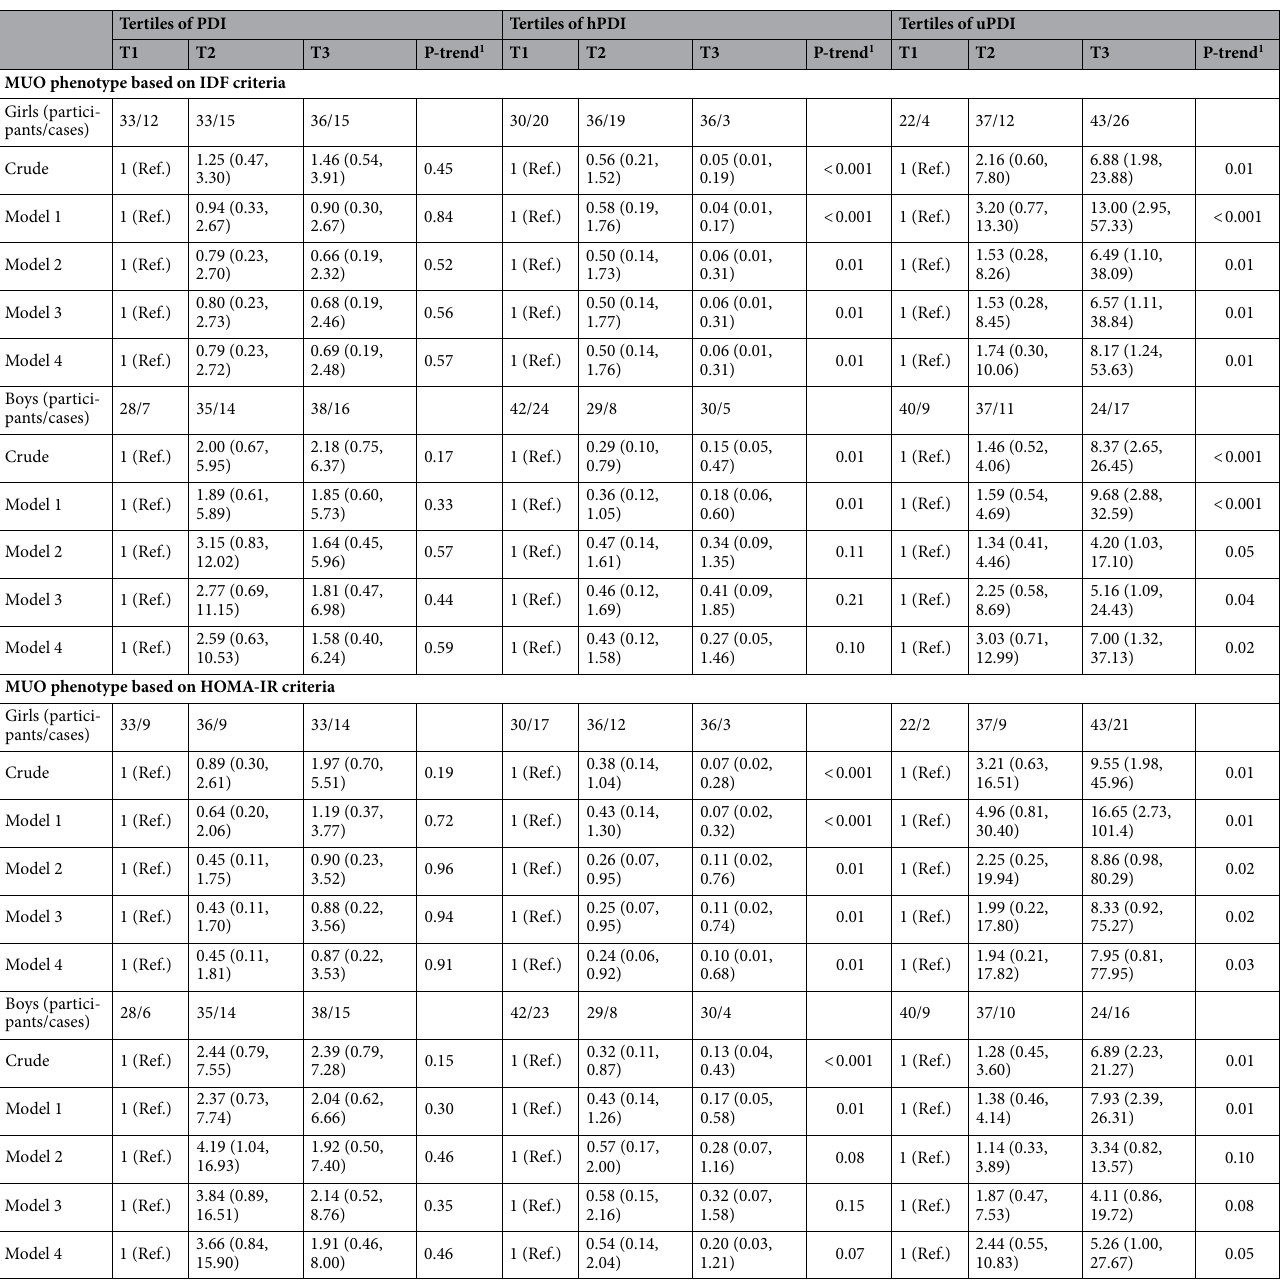
Table 4. Multivariate adjusted odds ratio (OR) and 95% confidence interval (CI) for MUO phenotype across tertiles of PDI, hPDI and uPDI, stratified by gender. All values are odds ratios and 95% confidence intervals. Model 1: Adjusted for age and energy intake. Model 2: Additionally, adjusted for physical activity and socioeconomic status (evaluated based on parental education level, parental job, family size, having car in the family, having computer/laptop, having personal room and having travel by using demographic questionnaire). Model 3: Additionally, adjusted for margarine and trans fatty acids. Model 4: Additionally, adjusted for Body Mass Index (BMI). 1 Obtained by the use of tertiles of PDI, hPDI, or uPDI as an ordinal variable in the